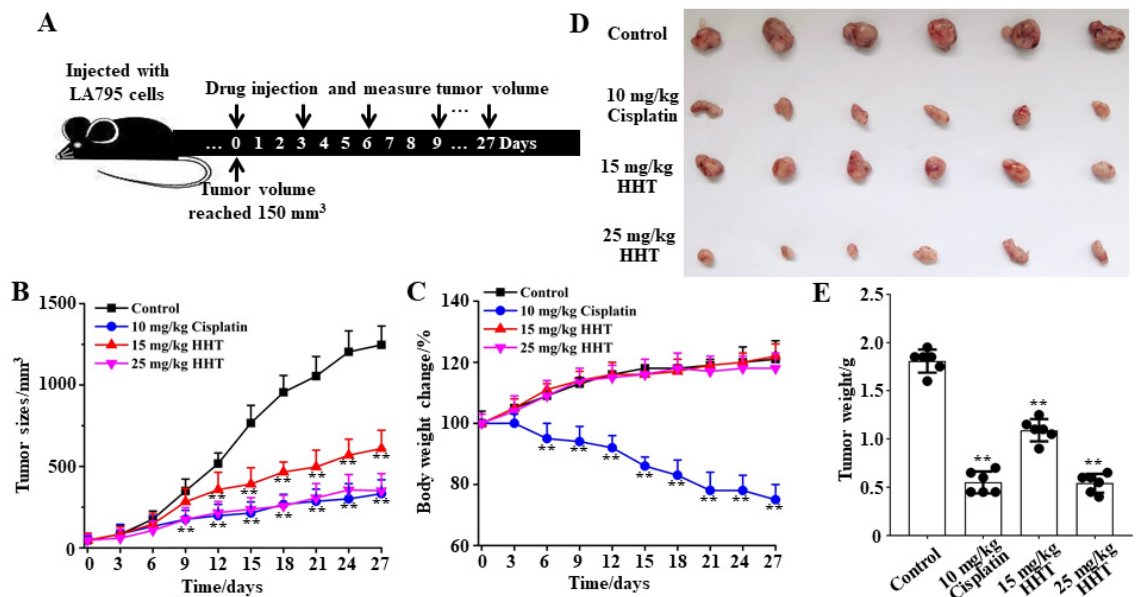
Figure 7. HHT inhibited the growth of lung adenocarcinomas in tumor xenograft mice. ( A ) Schematic diagram of the experimental protocol. ( B ) Tumor volume growth curve in different groups ( n = 6). ( C ) Body weight change curve in different groups ( n = 6). ( D ) Images of the tumor entity after 10 administrations of the drug ( n = 6). ( E ) Statistical results of the stripped tumor weight in ( D ) ( n = 6, ** P ＜ 0.01).